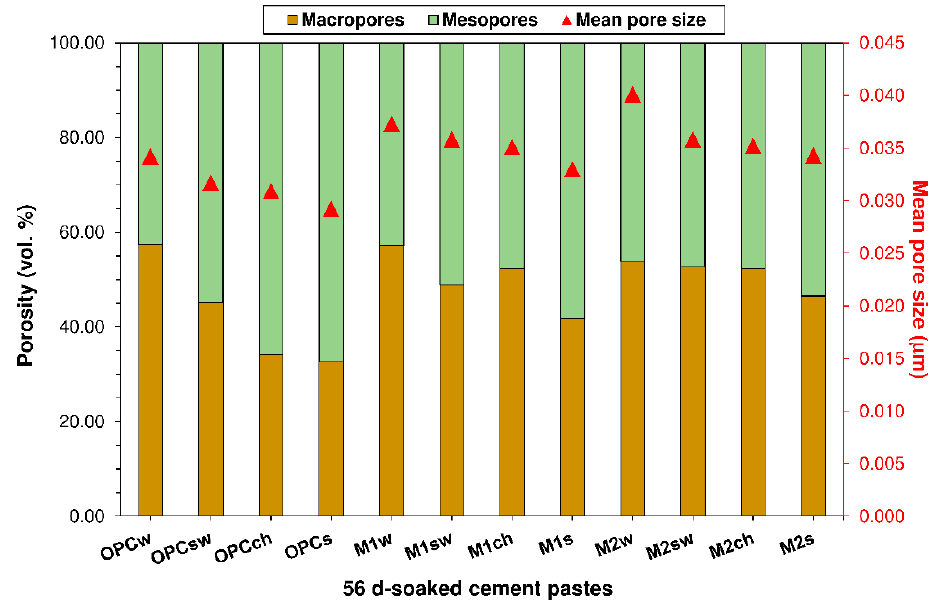
Figure 2. Pore systems in 56-d pastes exposed to distilled water (w), seawater (sw), 0.5 M NaCl (ch) or 0.3 M Na 2 SO 4 (s). or 0.3 M Na 2 SO 4